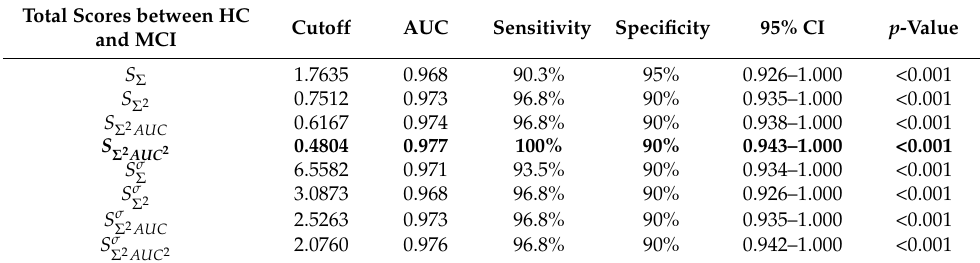
Table 10. Diagnostic score classification between HC and MCI.